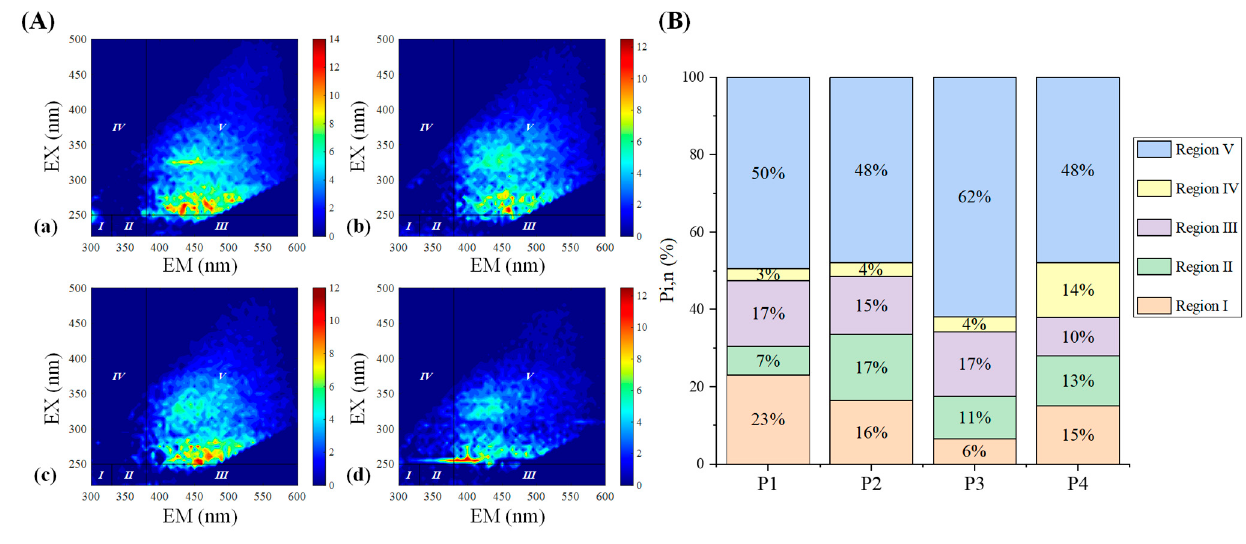
Figure 5. ( A ) Δ EEMs of different MW PPFA fractions binding with Fe(III) and fluorescence region integration (FRI) results with the addition of iron. ( a ) P1; ( b ) P2; ( c ) P3; ( d ) P4. ( B ) The percentage of contribution of different regions in Δ EEM for different MW PPFA fractions.